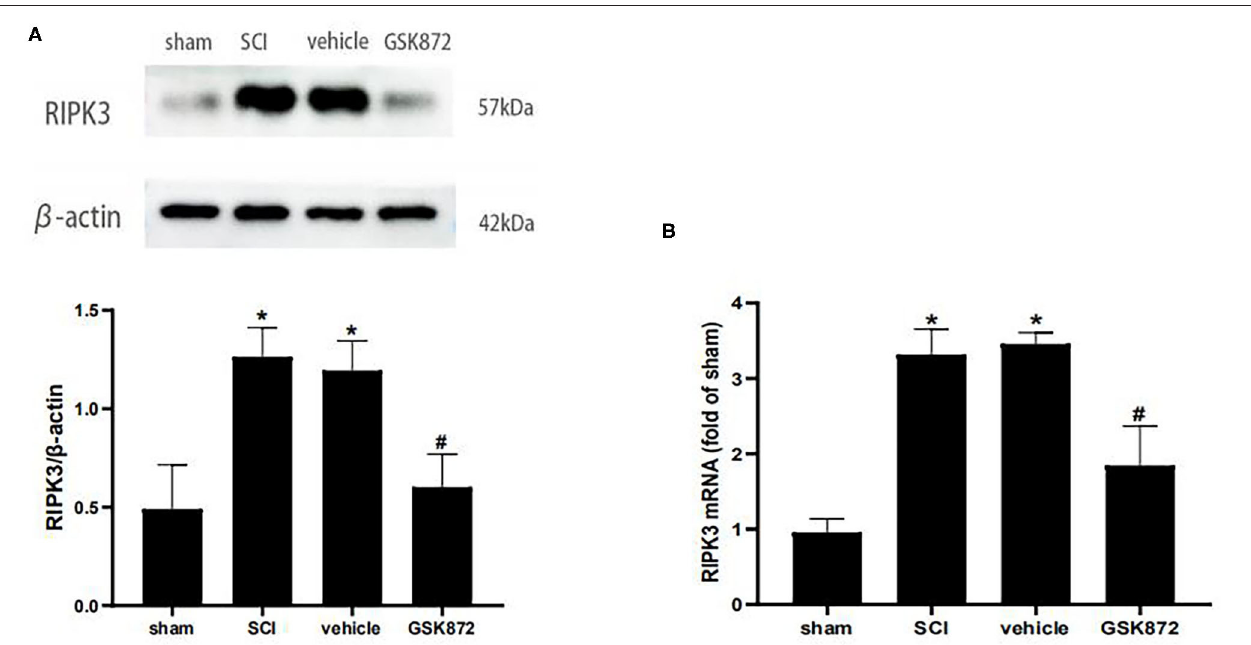
FIGURE 3 | GSK872 (10 µ l, 25 mmol/L) reduced the expression levels of RIPK3 after SCI. (A) The expression of RIPK3 in different groups, including sham, SCI, vehicle and GSK872 group, was measured by western blot analysis ( n = 5 for each group). (B) Quantitative analysis of the RIPK3 mRNA expressions in different groups including sham, SCI, vehicle and GSK872 group ( n = 4 for each group). All data were calculated as mean ± SD. * p < 0.05 vs. the sham group. # p < 0.05 vs. the vehicle group. Comparisons between multiple groups were carried out by one-way ANOVA and Turkey’s post-hoc